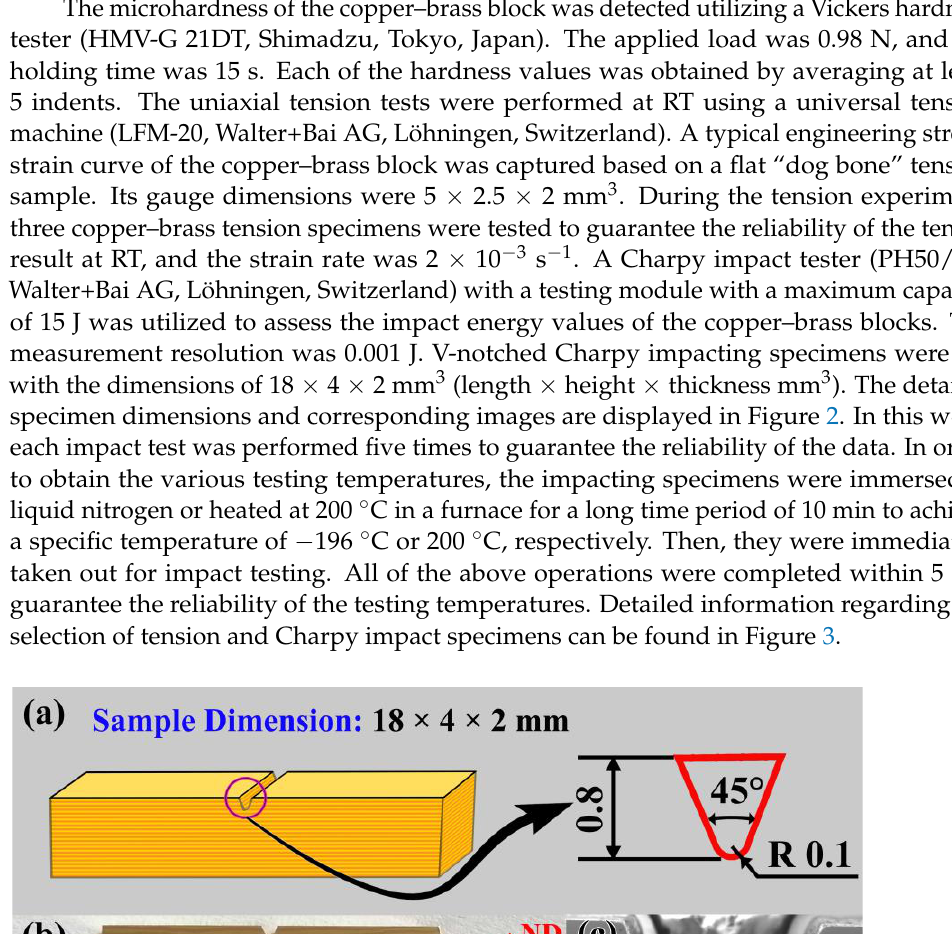
Figure 3. Schematic illustration of the selection of a tension sample and Charpy impact sample. 2.3. Microstructural Characterization Macro-images of the untested and tested impact samples were obtained using a Nikon camera. A field emission scanning electron microscope (SEM, Quant 250 FEG, FEI, Hillsboro, OR, USA) with an accelerating voltage of 20 keV was used to capture the fracture morphologies for the Charpy impacting samples impacted at various temperatures. The original and deformed microstructures were analyzed using an electron backscattering diffraction (EBSD) technique, which was conducted on the above SEM machine. The accelerating voltage and step size for the EBSD testing were 15 keV and 200 – 300 nm, respectively. The EBSD specimens were firstly prepared via mechanical polishing, and then they were polished at 3.8 V in a phosphoric acid (85 mL) + H 2 O (15 mL) solution for 40 s. 3. Results and Discussion Figure 4 presents the microstructure of the multilayered copper – brass block. As can be observed from Figure 4a,b, the copper and brass layers exhibit a diverse structure. The copper layer shows a deformed lamellar structure with numerous low-angle boundaries (LAGs), while the brass layer shows an annealed structure consisting of many equiaxed